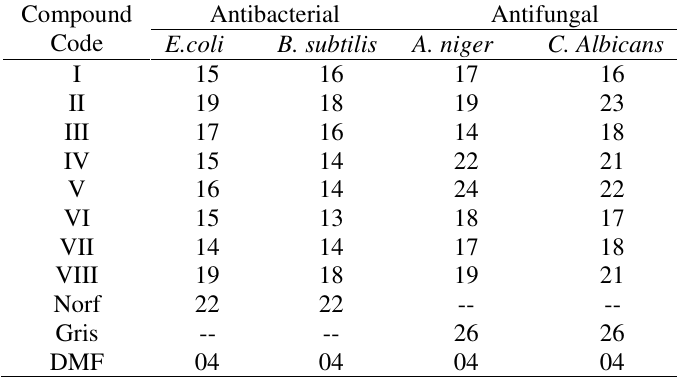
Table 3. Anti-microbial activities of